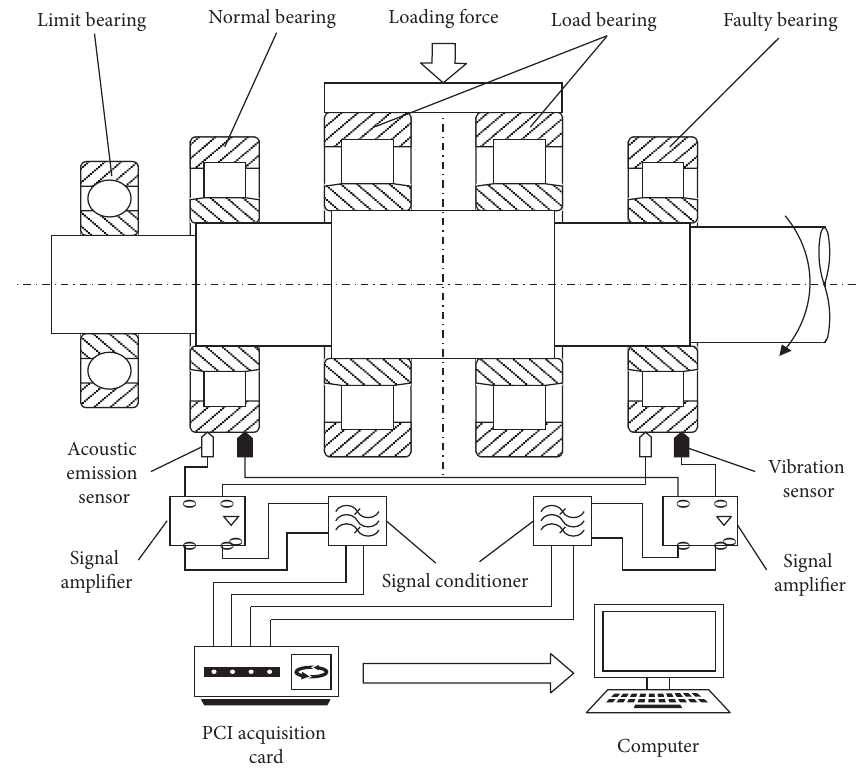
Figure 1: Schematic diagram of the rolling bearing test and information acquisition system.